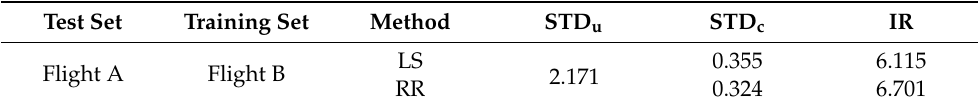
Figure 6. LS and RR compensation results for flight A. Table 1. Comparison of compensation results of LS and RR.